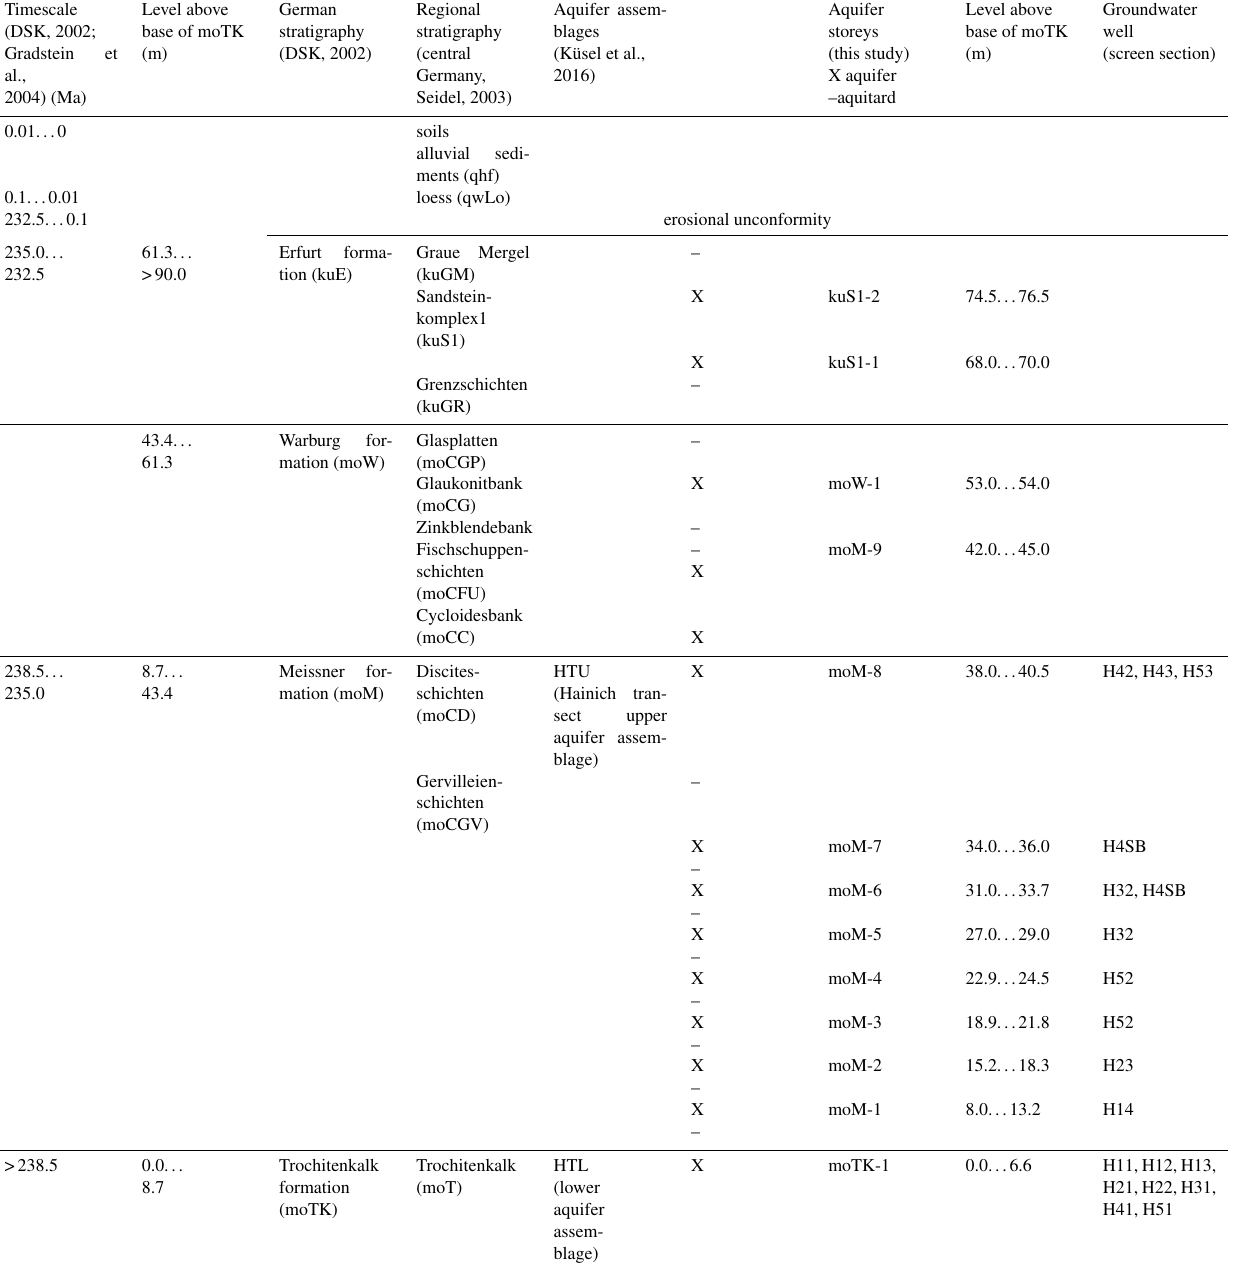
Table 2. Hydrostratigraphic standard section: relative positions of aquifer storeys (this study) in comparison with a published classification (Küsel et al., 2016) in the context of the German stratigraphy and the timescale. Timescale (DSK, 2002; Gradstein et